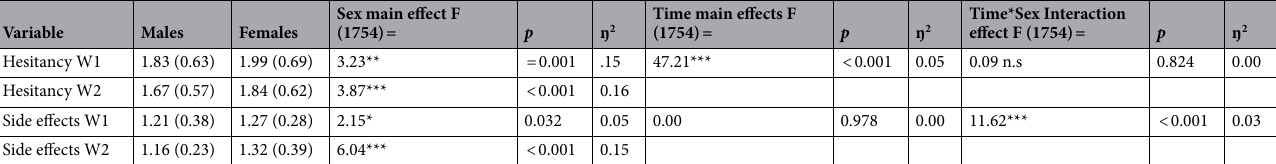
Table 2. Time and Sex main effects and their interaction on vaccine hesitancy and on side-effects based on Repeated measure ANOVA analyses. N = 756, * p < 0.05, * * p < 0.01, * * * p < 0.001.